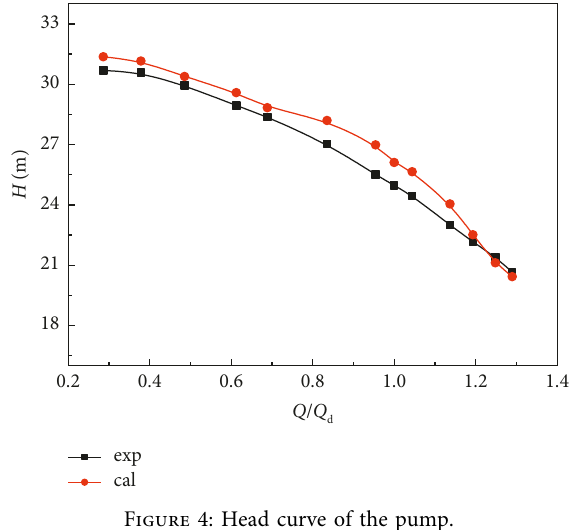
Figure 4: Head curve of the pump.